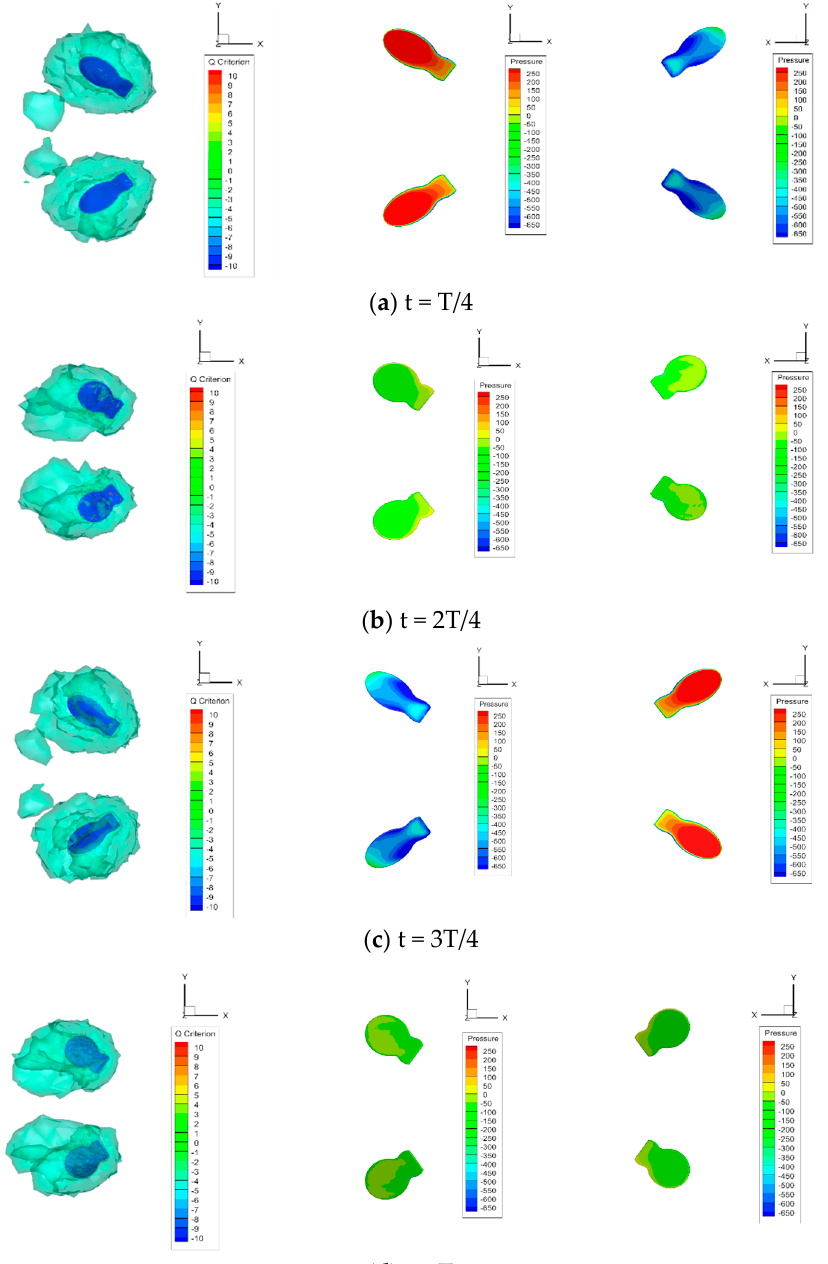
Figure 8. Simulation of the swimming motion. The vortex volume cloud is shown on the left, the pressure distribution on the upstream surface is shown in the middle, and the pressure distribution on the downstream surface is shown on the right.